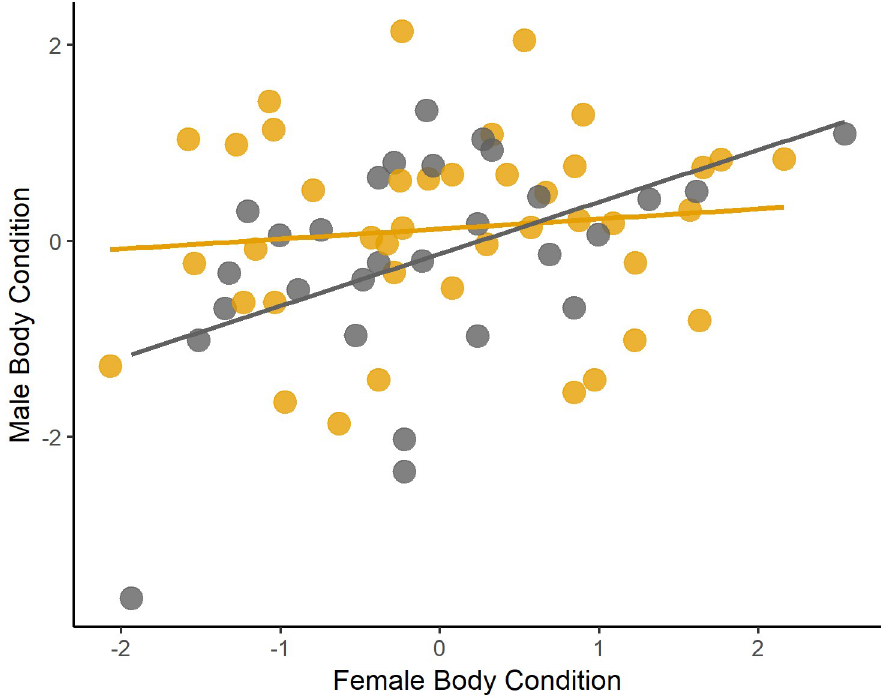
Fig 3. Relationship between female and male body condition within pairs split into 2 classes. After second-year males’ pairs (yellow circles) ( R 2 = 0.11, P = 0.49, n = 41) and second-year males’ pairs (grey circles) ( R 2 = 0.48, P = 0.008, n =